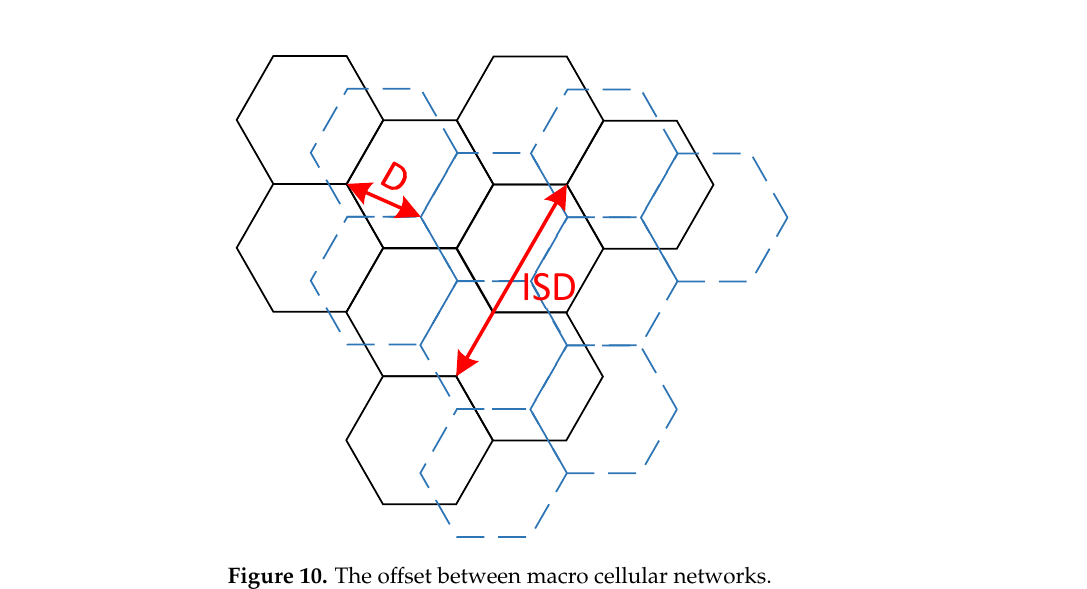
Figure 9. Interference scenario network topology. Offset D indicates the distance between the interferer system and the victim system. Figure 10 represents the offset between the two systems. When D = 0, it indicates the com- mon location of the two systems, and when D = R = ISD/ √ 3, it indicates that the interfere system is at the cell edge of the victim system.